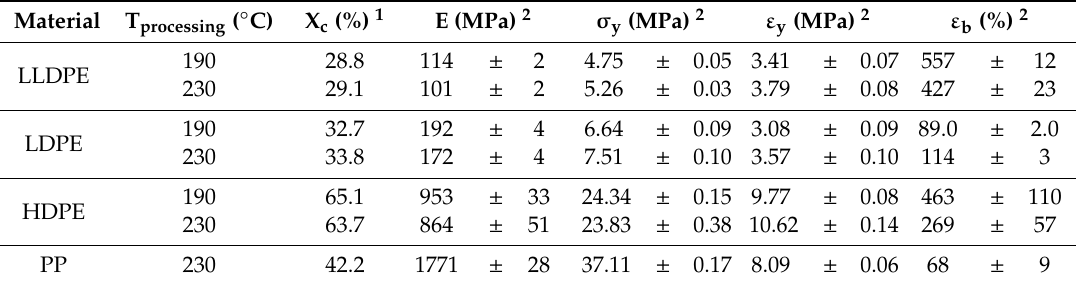
Table 3. Properties of used mono